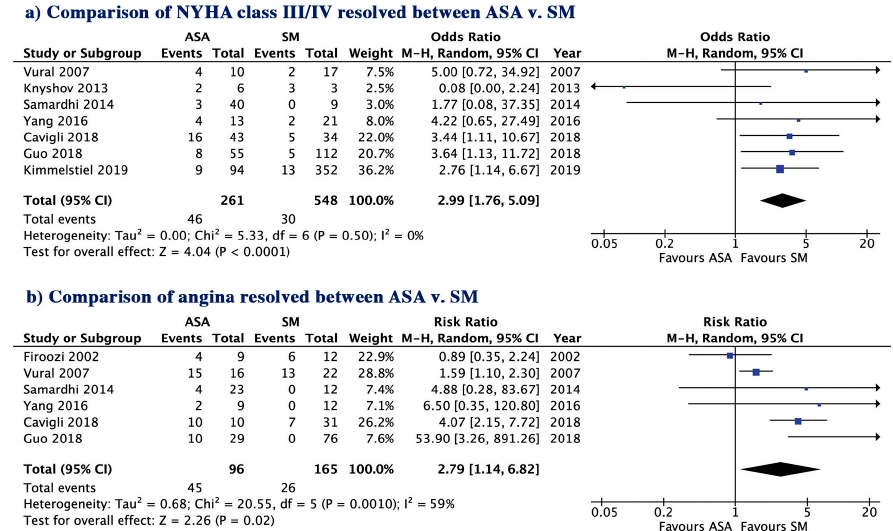
Figure 6. Comparison of clinical improvements between ASA vs. SM; ( a ) NYHA class; ( b ) Angina. ASA, alcohol septal ablation; SM, surgical myectomy; CI, confidence interval. NYHA, New York Heart Association